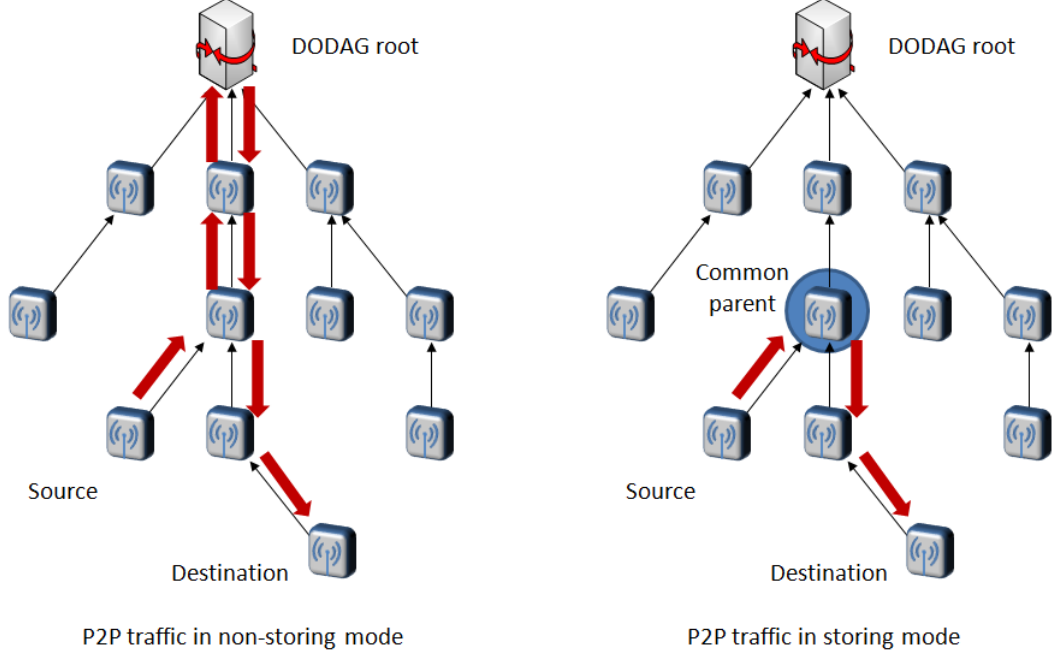
Figure 9. Packet flow for point-to-point traffic between two nodes in an RPL